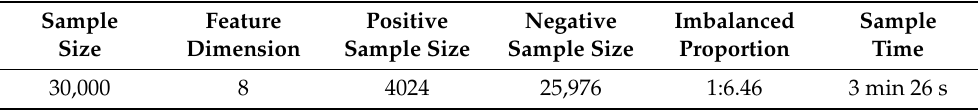
Table 2. The experimental dataset.